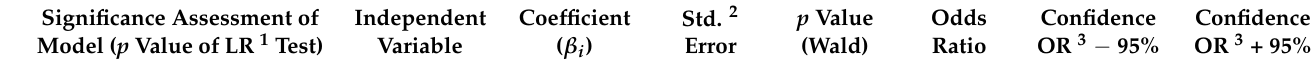
Table 1. Results logistic regression models. Passive surveillance model (found